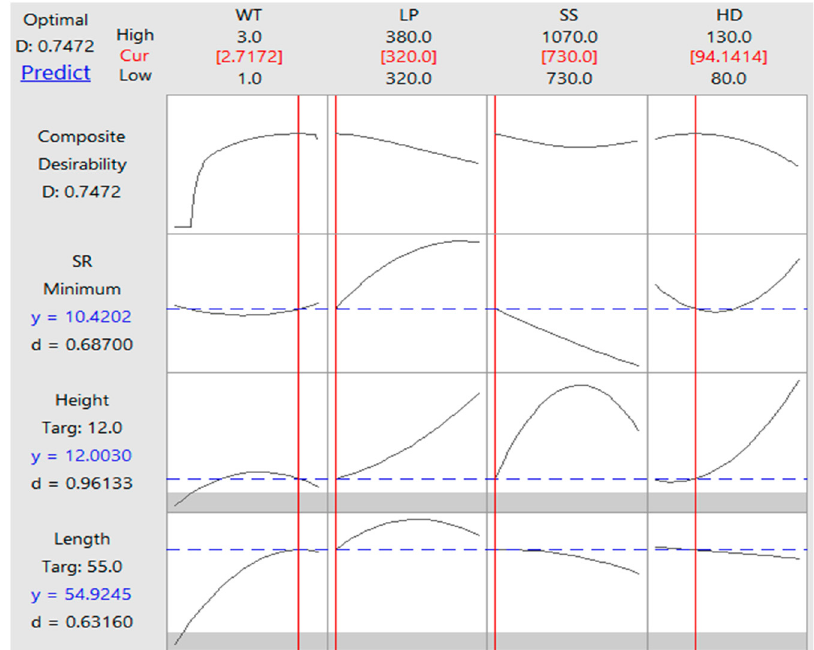
Figure 11. Optimization plot for SR, height, and length.